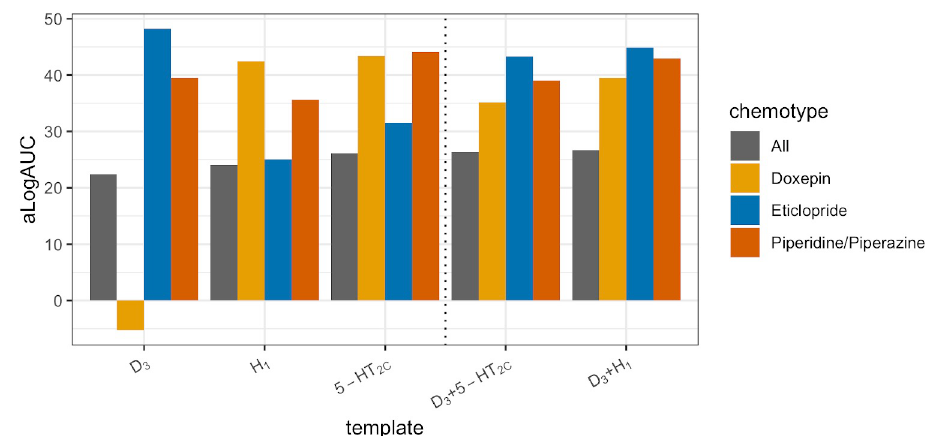
Fig 6. Influence of template on enrichment of ligand chemotypes. Enrichment (aLogAUC) of eticlopride- (blue bars), doxepin- (yellow bars), piperidine/piperazine-like (red bars), and all (grey bars) D 2 R ligands by D 2 R homology models. Homology models based on three different templates (D 3 R, H 1 R, and 5-HT 2C R) and ensemble enrichments of the D 3 R model combined with either the H 1 R and 5-HT 2C R models were